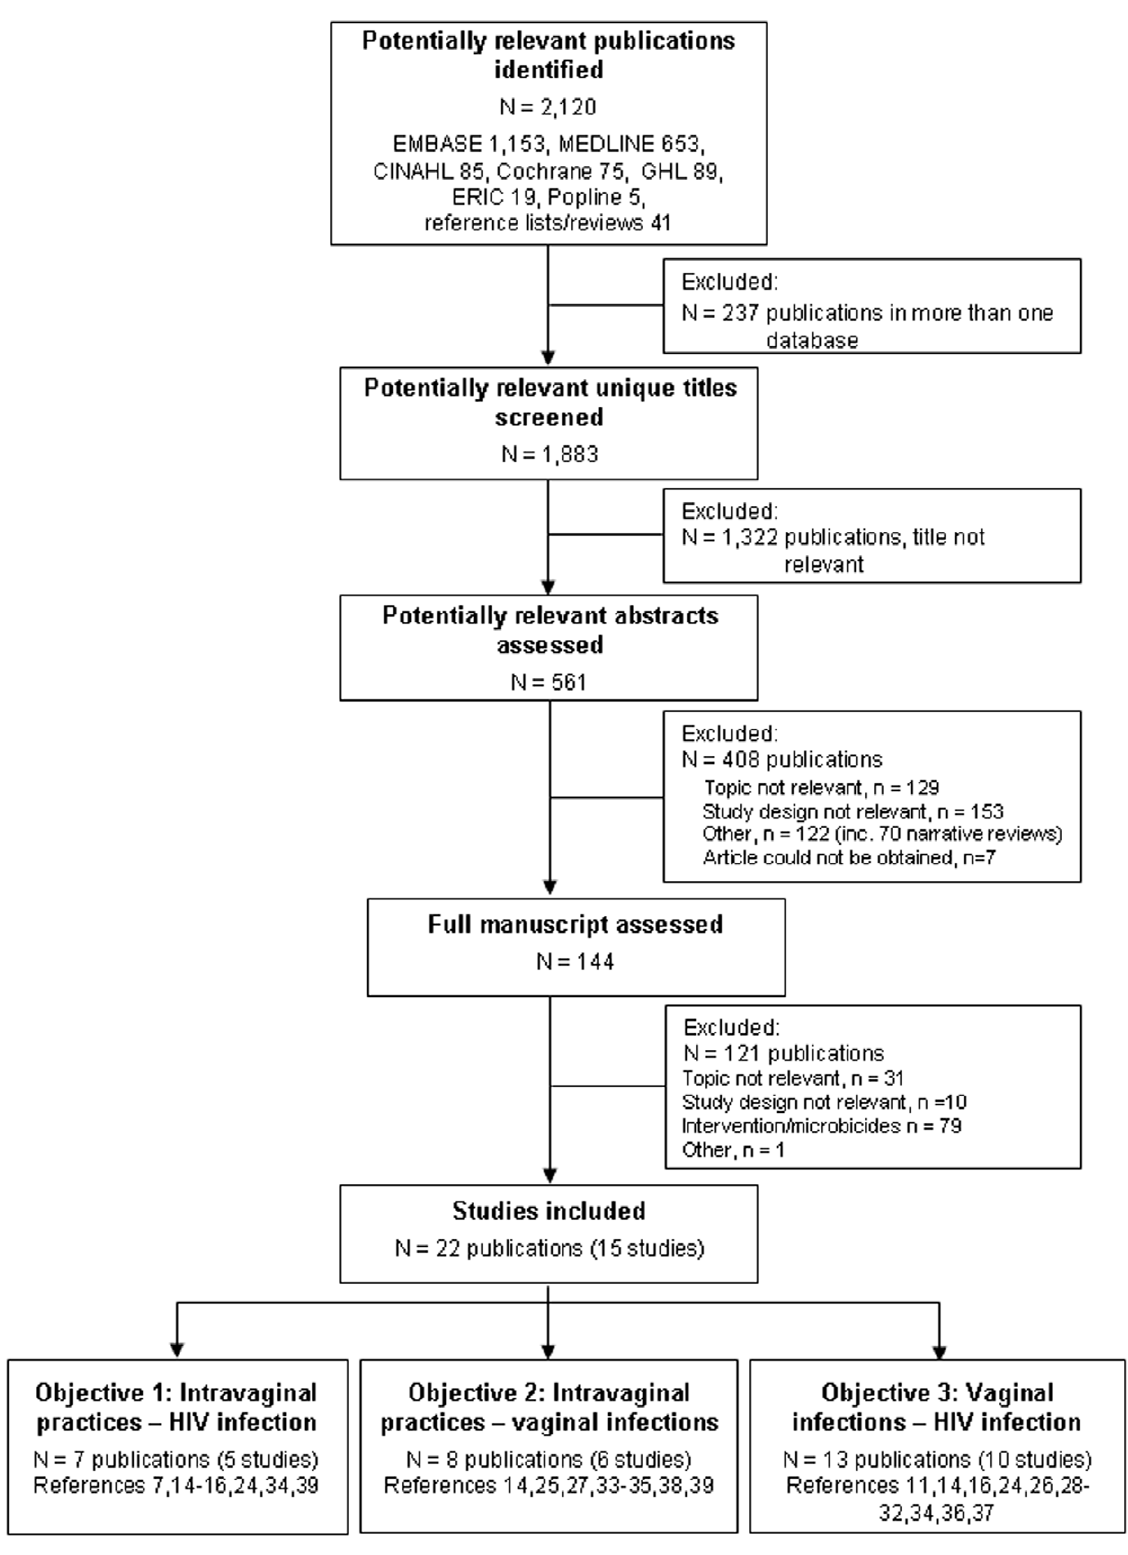
Figure 2. Flow chart of identification and selection of studies for inclusion. Steps followed to identify relevant studies and select those eligible for inclusion in the review. Publications and studies in the box ‘Studies included’ could address multiple objectives and are included in each relevant ‘Objective’ below. EMBASE, Excerpta Medica Database; MEDLINE (Ovid), Medical Literature Analysis and Retrieval System Online; CINAHL, Cumulative Index to Nursing and Allied Health Literature; Cochrane, Cochrane Library (John Wiley); ERIC, Educational Resources Information Centre; GHL, Global Health Library; Popline, Population Information Online.